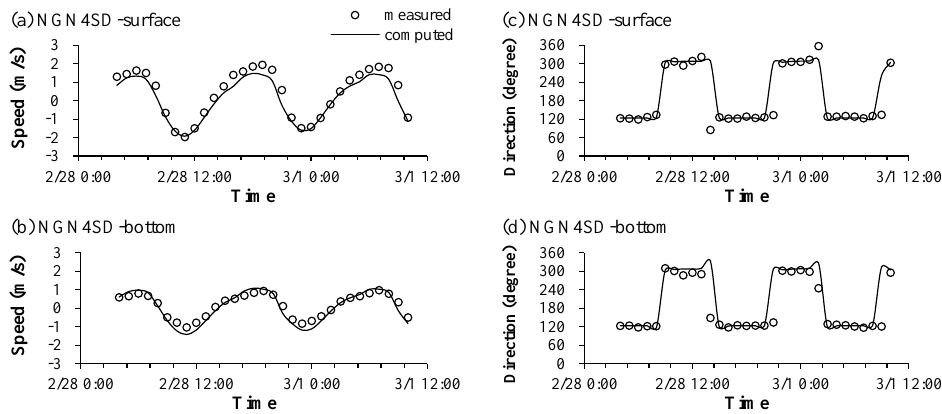
Figure 6. Verification of surface and bottom current velocity and direction in 2014.